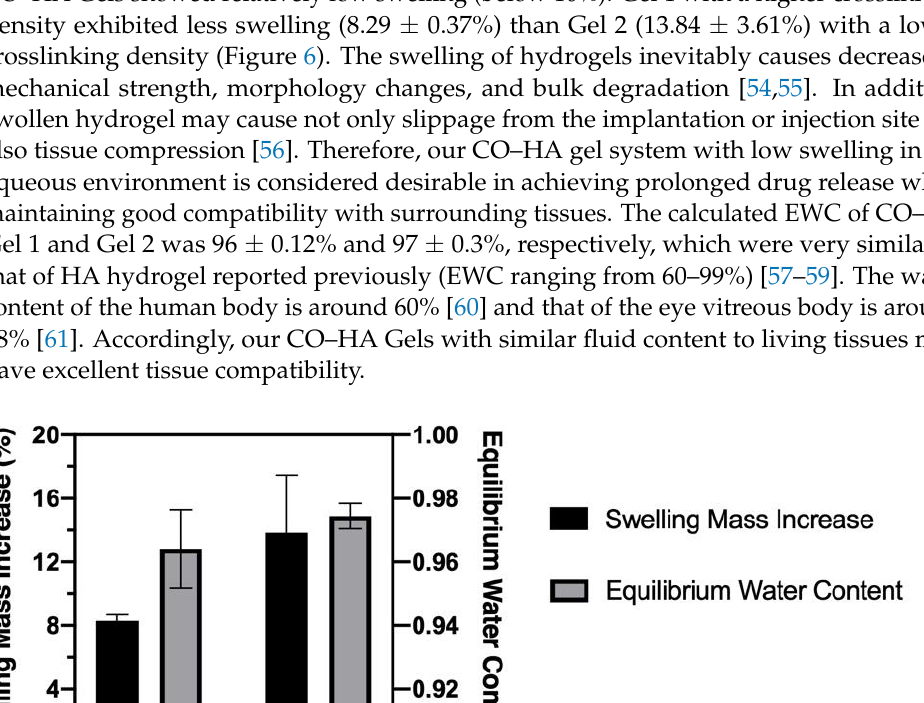
Figure 5. Cryo-SEM images of Gel 1 (20 kDa PEG) ( a , b ) and Gel 2 (40 kDa PEG) ( c , d ). Scale bar: ( a , c ) 40 μ m; ( b , d ) 20 μ m.